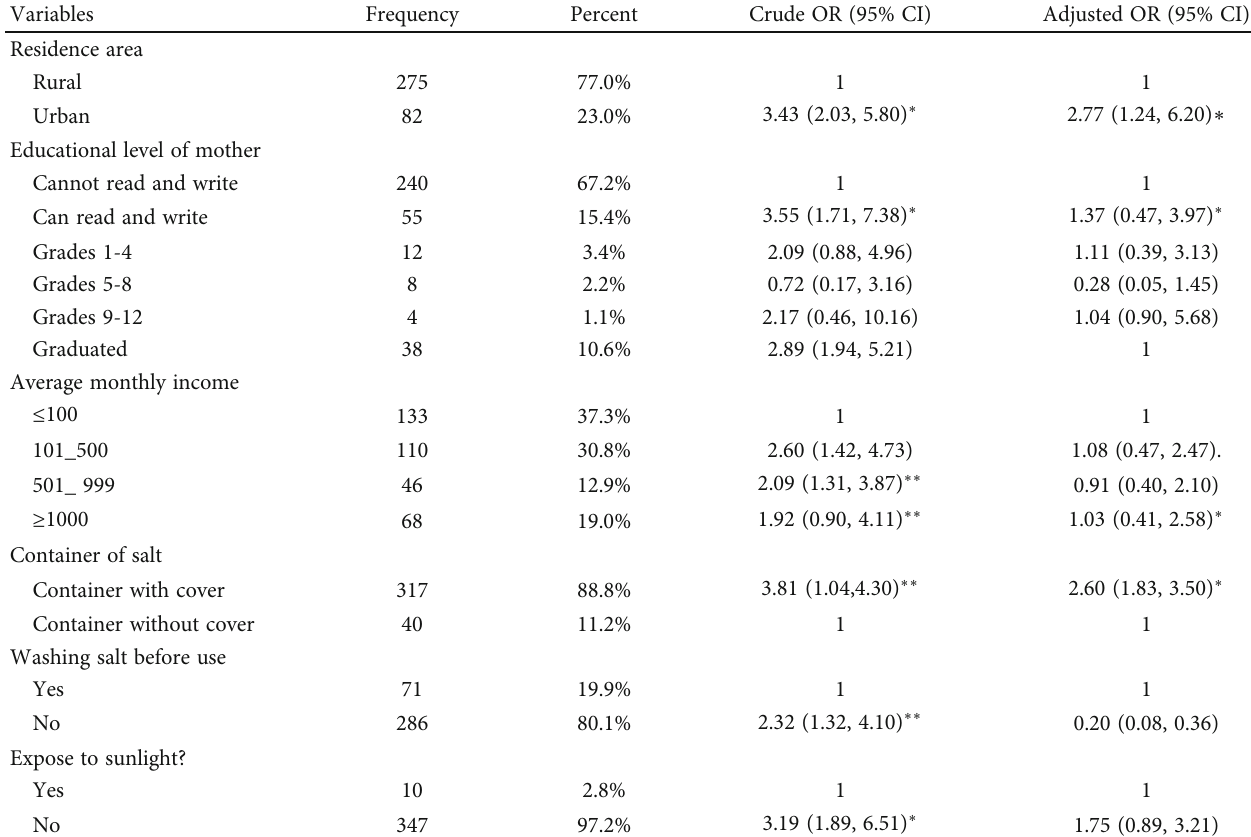
Table 6: Factors associated with practice of iodized salt in the study